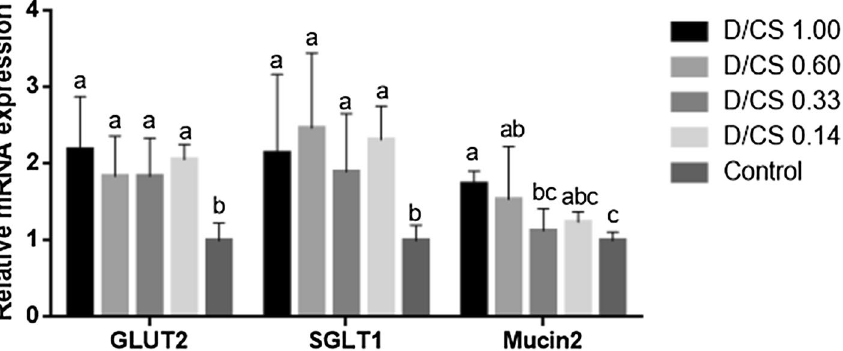
Figure 2. The effects of NFD on the relative gene expression of GLUT-2 , SGLT-1 and Mucin-2 ( n = 6). Labeled means without a common letter are significantly different, P <